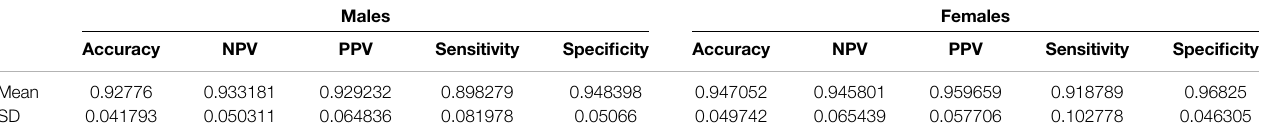
TABLE 1 | FSS male and female random forest prediction accuracy, NPV, PPV, sensitivity, and speci fi city for 20,000 iterations.